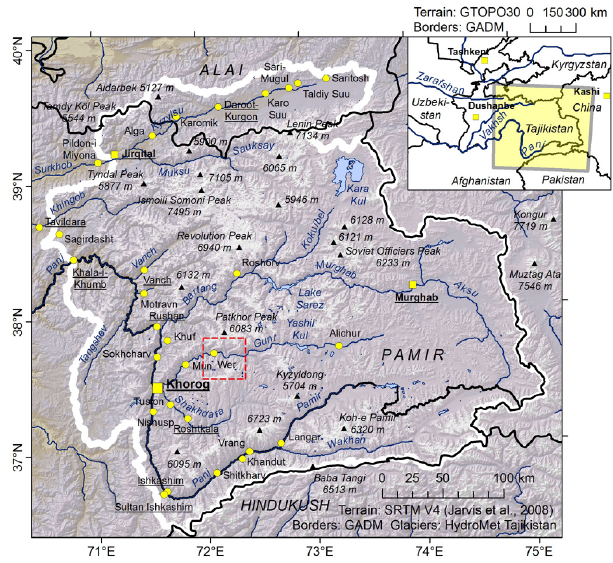
Fig. 2. Study area. The dashed red rectangle delimits the area shown in Fig. 11, the yellow polygon in the upper right inset indicates the extent of the main